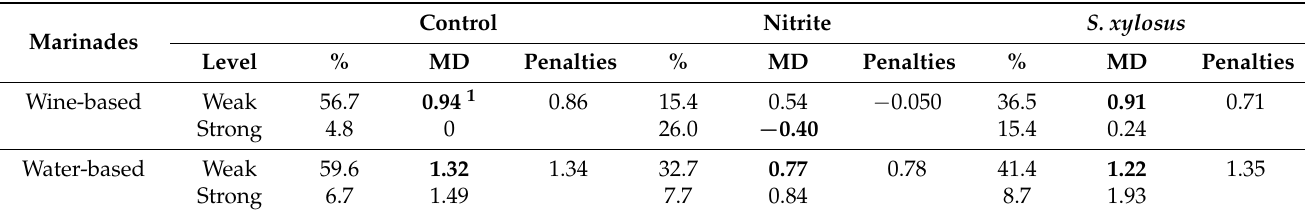
Table 4. Mean drop (MD) and penalties associated with a non-ideal evaluation of the cured loins’ color.